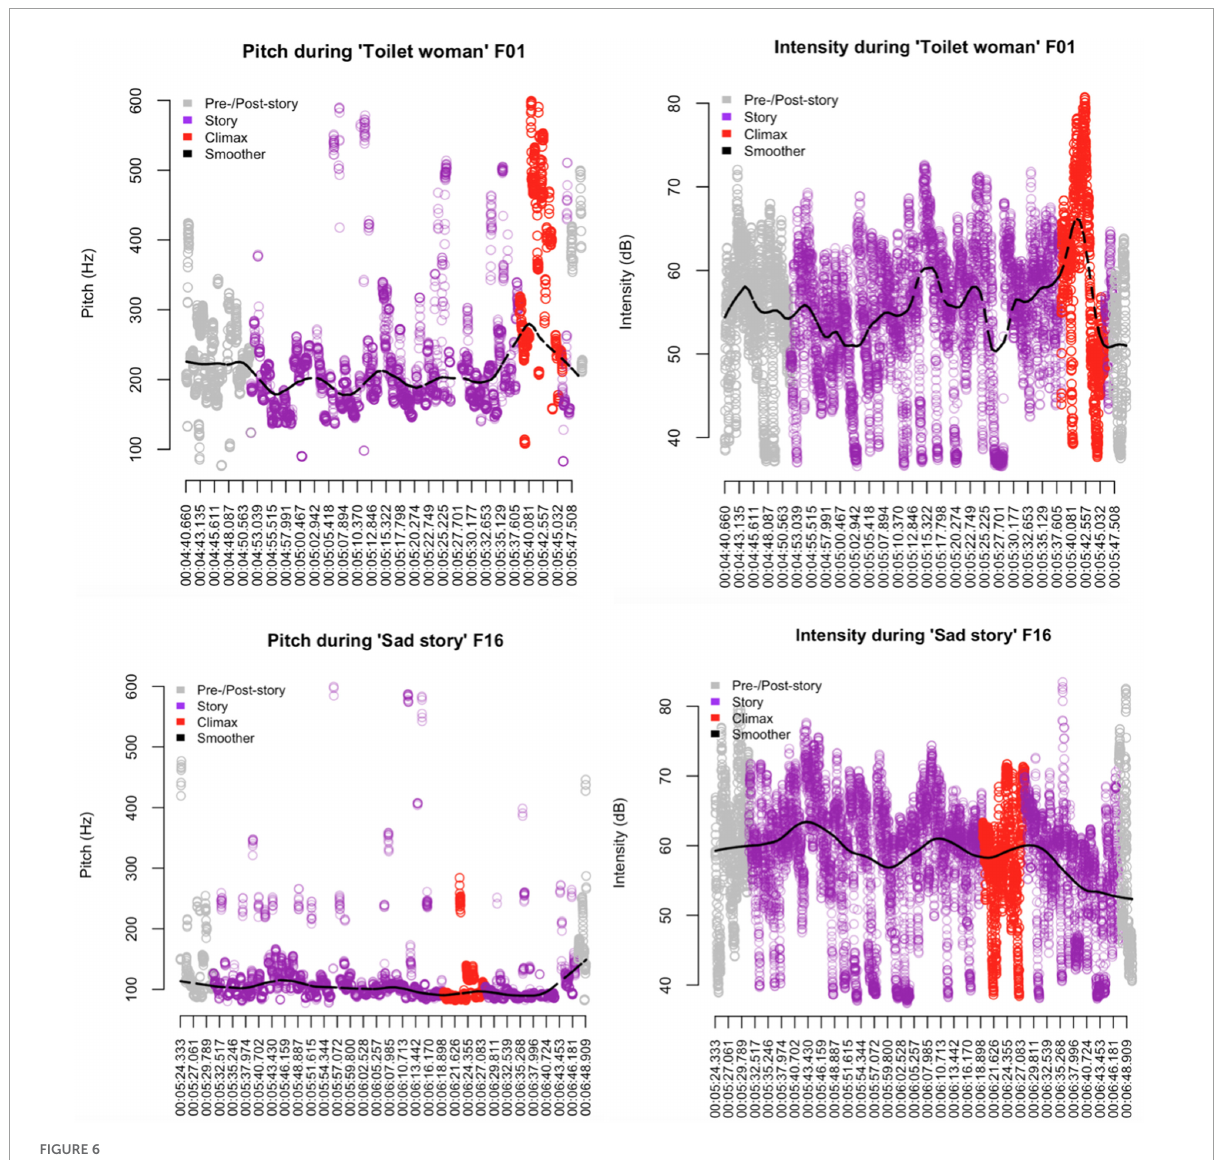
FIGURE6 Pitch and intensity in “Toilet woman” vs. “Sad story”; smoothers (black line) represent locally weighted regression